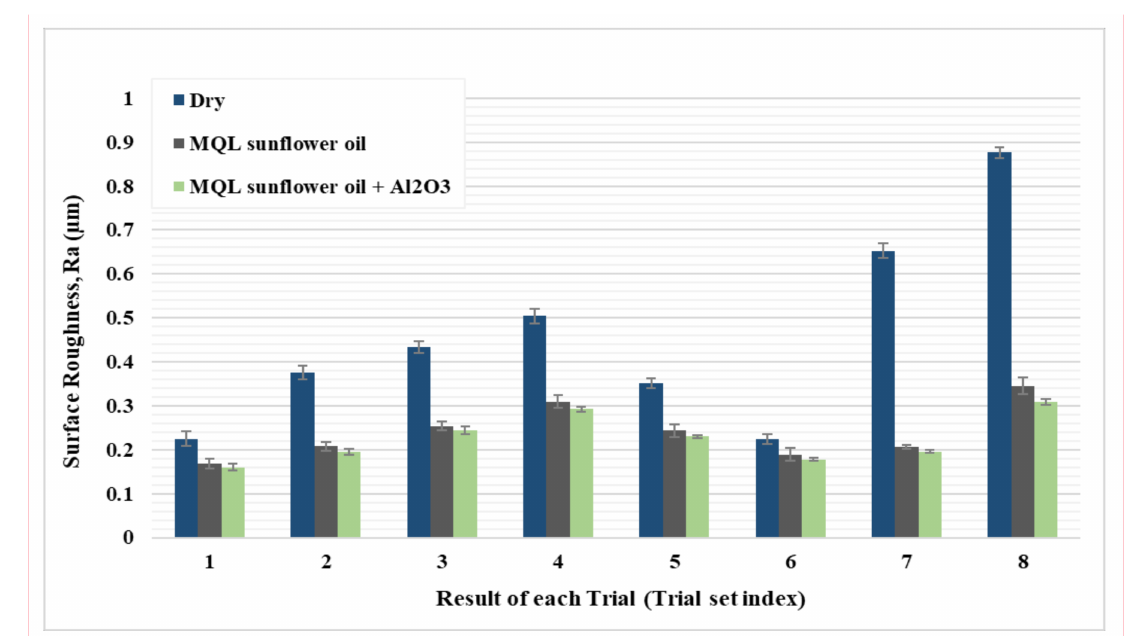
Figure 9. Comparison between the three coolant types (Dry, MQL, and MQL+ Al 2 O 3 ) on measured surface